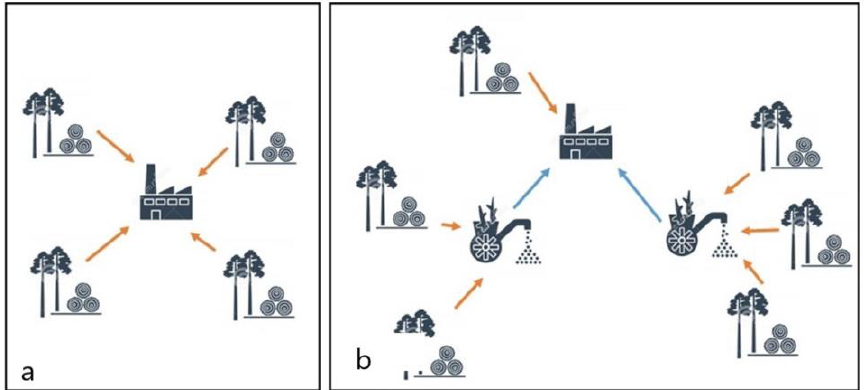
Figure 1. ( a ). traditional forest biomass supply chain, showing transportation from forest directly to central manufacturing facility; ( b ). bio-hub configuration, showing intermediate processing centers located between forest and central processing facility.